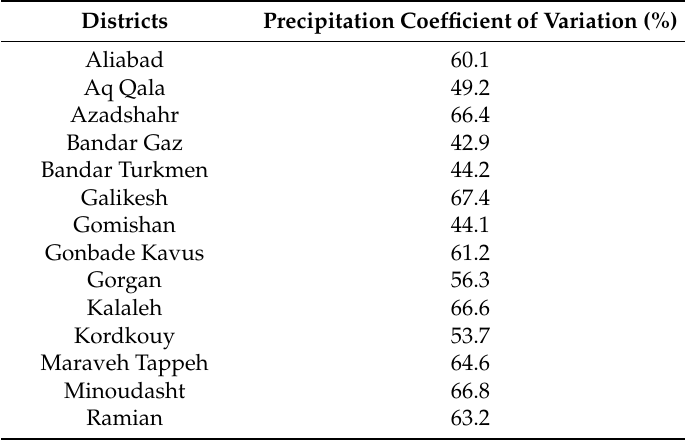
Figure 3. Water availability in different districts of Golestan Province along with per-capita water availability shown in black squares. The dash-line indicates the Falkenmark Threshold which is used to illustrate the status of physical water scarcity in different districts. The y-axis represents the logarithm of available water volume in square meters for better comparison between surface water and groundwater sources. Table 3. Precipitation coefficient of variation in different districts of Golestan